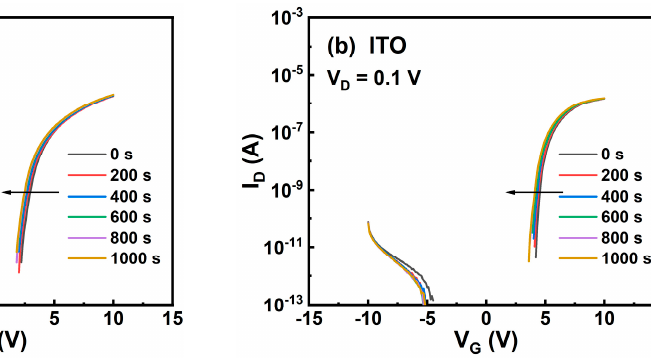
Figure 6. TEM images of the interfacial microstructures between ITO and the metal electrodes: ( a ) Al, ( b ) ITO, ( c ) Ti, and ( d ) Mo.